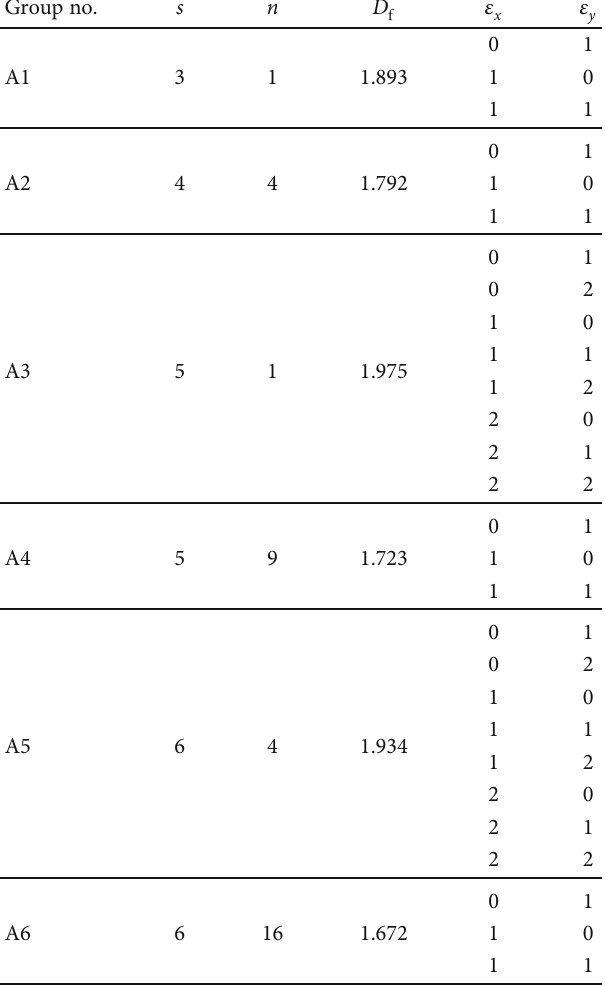
ε i = 1 , (b) i = 2 , and (c) i = 3 x = 1 , and y = 1 : (a) Table 2: Parameters of the anisotropic Sierpinski carpet models. Group